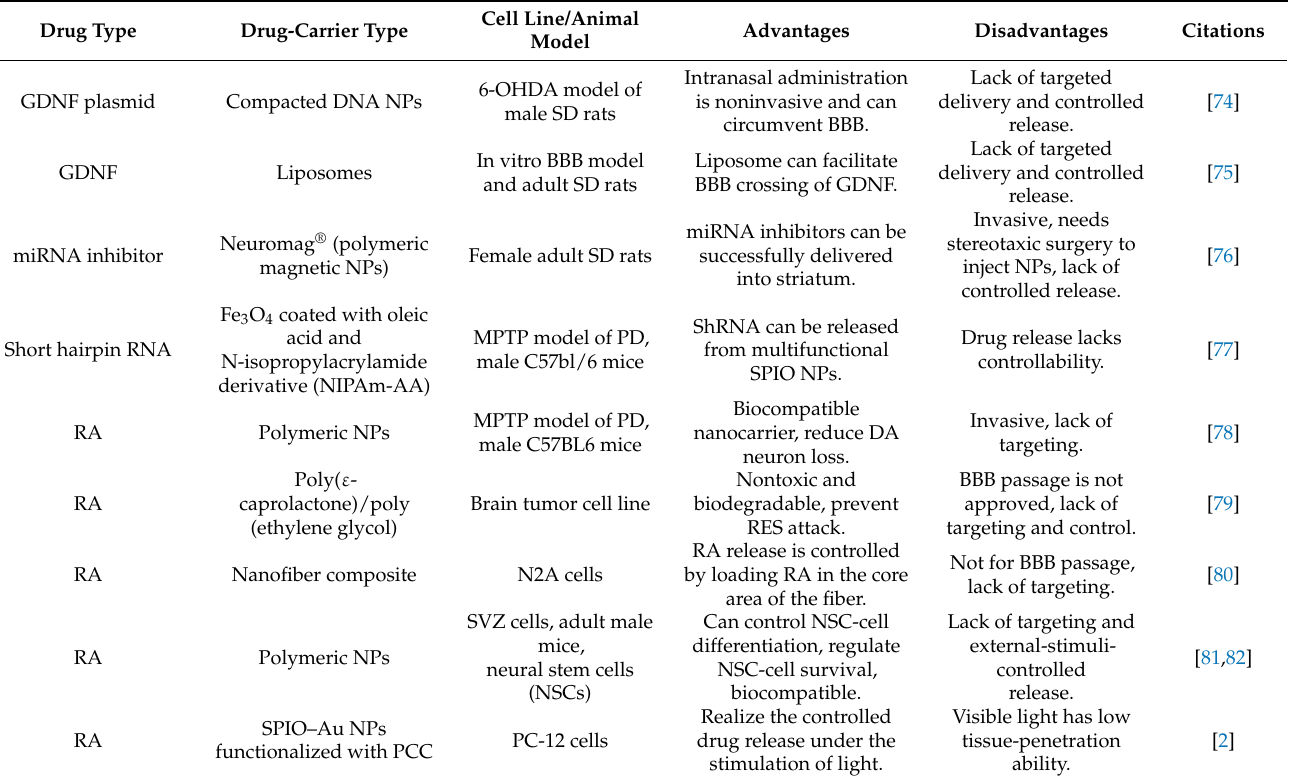
Table 2. Summary of advantages and disadvantages of current developed drug-delivery systems for the delivery of GDNF, miRNA, and RA for brain